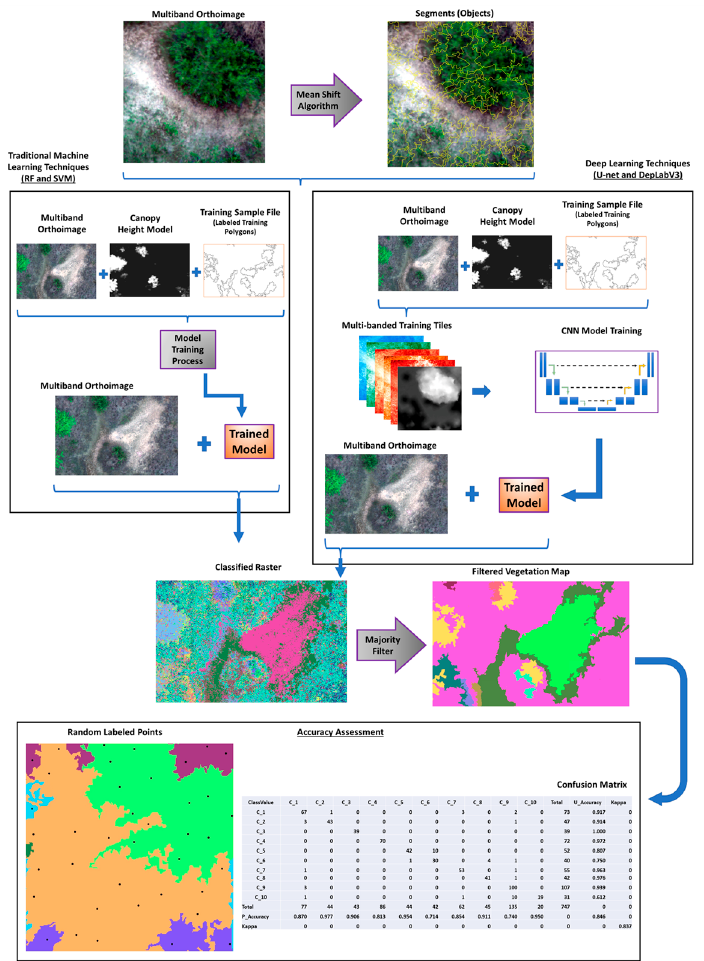
Figure 1. Workflow recommended in this paper for traditional machine learning techniques and deep learning algorithms.